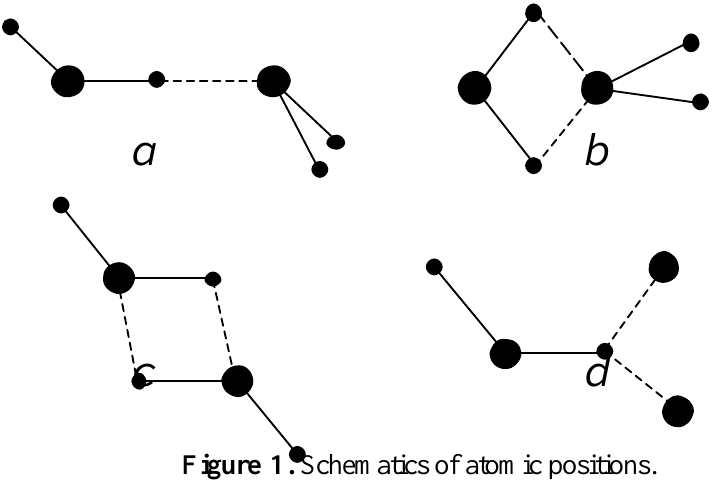
Figure 1. Schematics of atomic positions. a – linear, b - bifurcated, c - inverted, d –